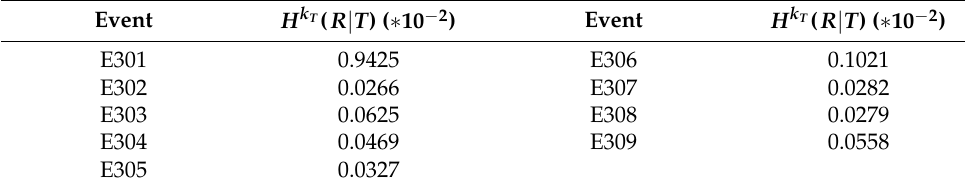
Table 6. Importance of each bottom event considering